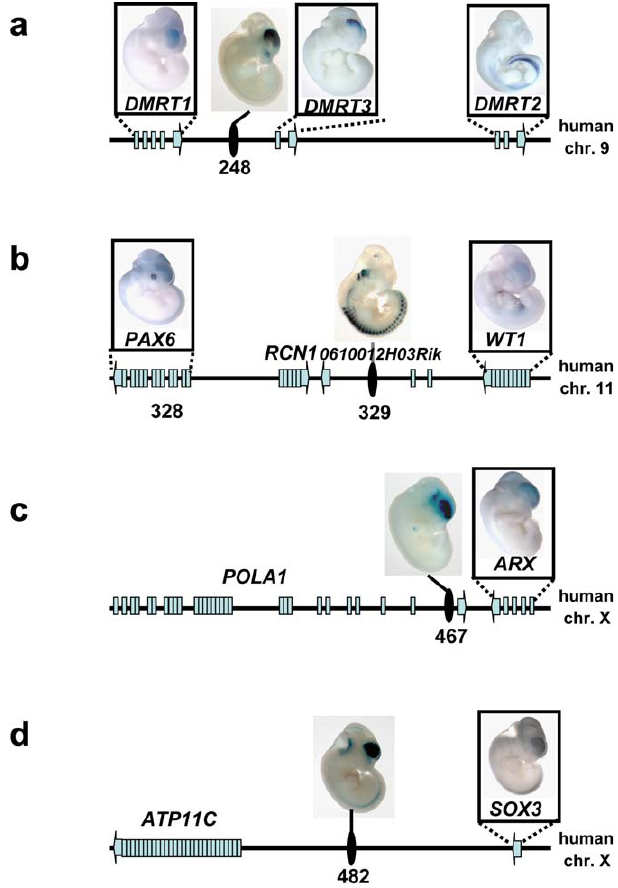
Figure 1. Schematic of the Human Genomic Locations of the Four Ultraconserved Elements That Were Deleted (A) uc248 region; (B) uc329 region; (C) uc467 region; (D) uc482 region. A black oval represents each ultraconserved element, while the embryos above the schematics represent observed positive enhancer activities captured through transgenic mouse testing at e11.5 for that element [6]. Stained embryos in boxes represent whole-mount in situ hybridizations of the specific gene at e11.5 (genes without stained embryos were negative for this assay at this time point). Exons and noncoding elements not shown to